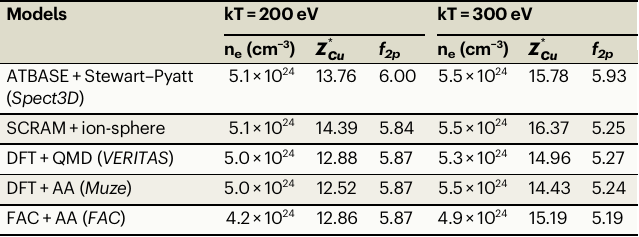
Table 1 | Comparisons of free-electron density (n e ), average ionization Z * Cu and 2p-population ( f 2p ) of Cu in warm-/hot- dense plasmas